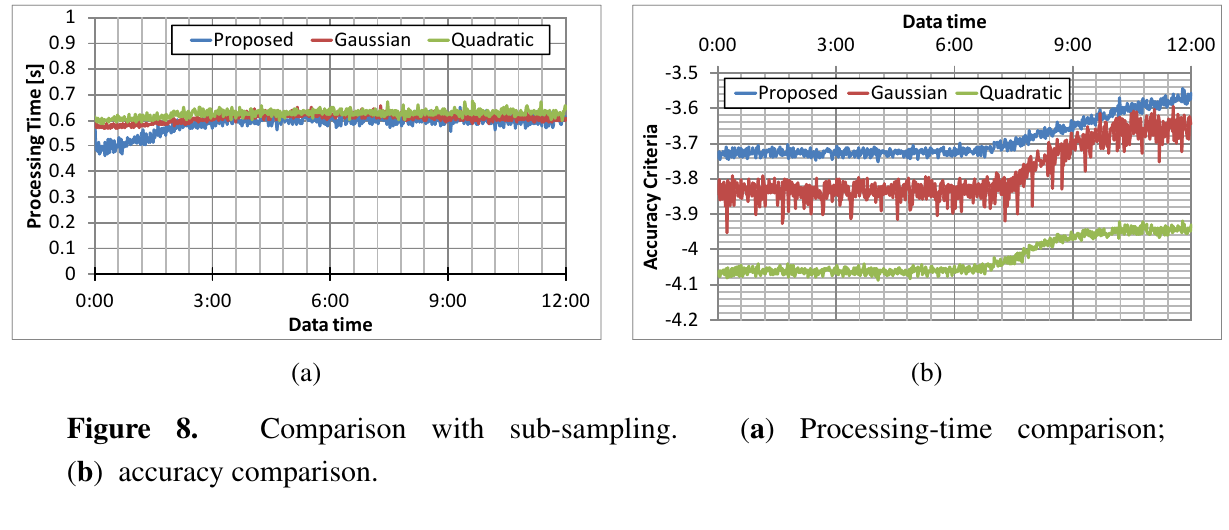
Figure 8. Comparison with sub-sampling. ( a ) Processing-time comparison; ( b ) accuracy comparison.